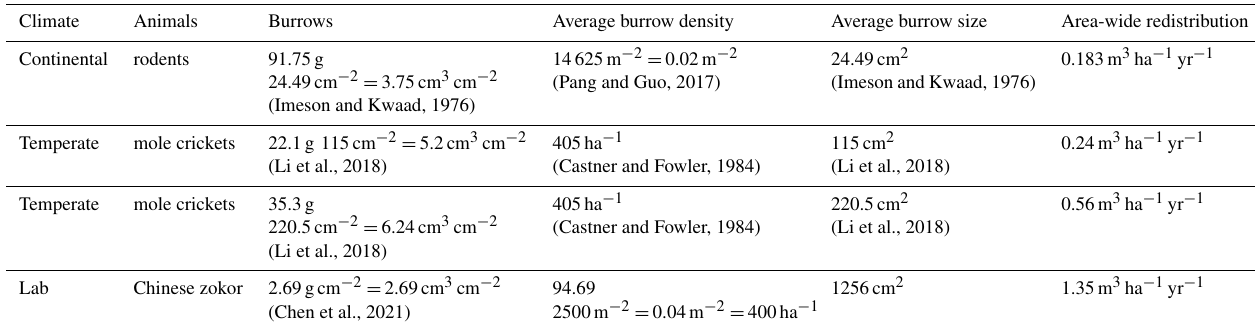
Table A7. Review of studies that estimated the sediment redistribution within burrows, average burrow density as found in the literature, and area-wide yearly contribution of burrowing animals to sediment